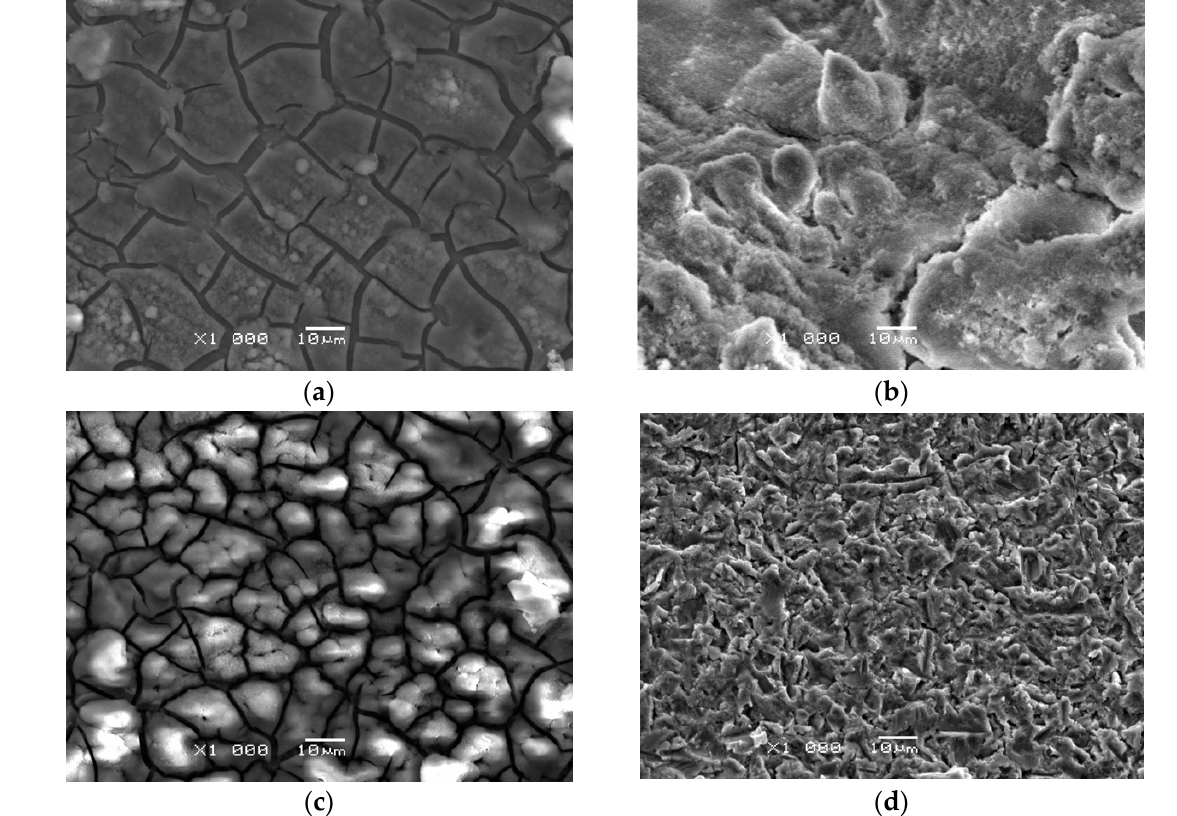
Figure 5. SEM image of the surface morphology: ( a ) CaP coating deposited at − 1.5 V for 30 min at 20 °C with a thickness of 0.7(1) µm; ( b ) CaP coating deposited at − 3 V for 30 min at 20 °C with a thickness of 11.3(7) µm; ( c ) CaP coating deposited at − 10 V for 30 min at 20 °C with a thickness of 20.1(9) µm; ( d ) CpTi G4 substrate.